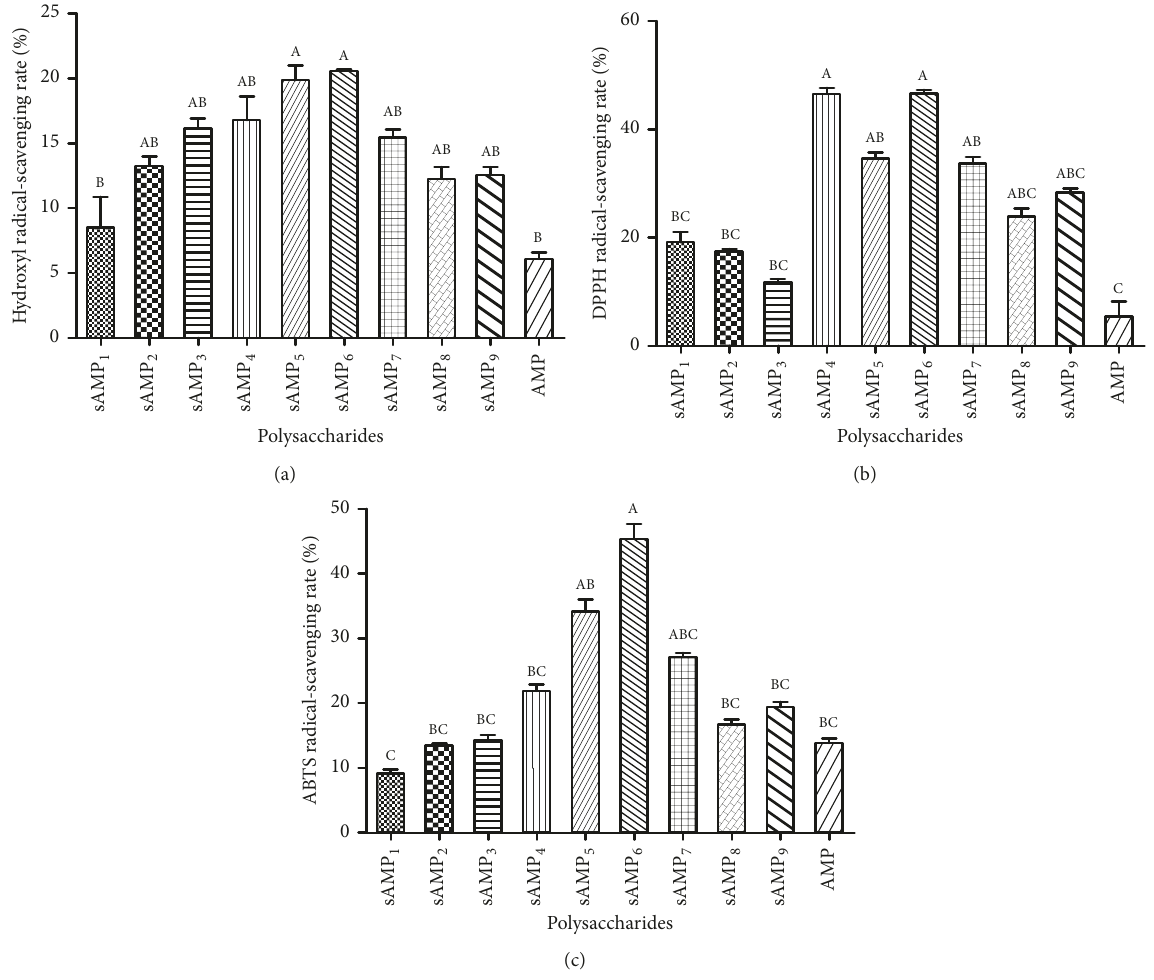
Figure 4: The radical-scavenging rate of every group in vitro test. (a) Hydroxyl radical-scavenging rate. (b) DPPH radical-scavenging rate. (c) ABTS radical-scavenging rate. Bars without the same superscripts (A–C) differ significantly ( p < 0.05).